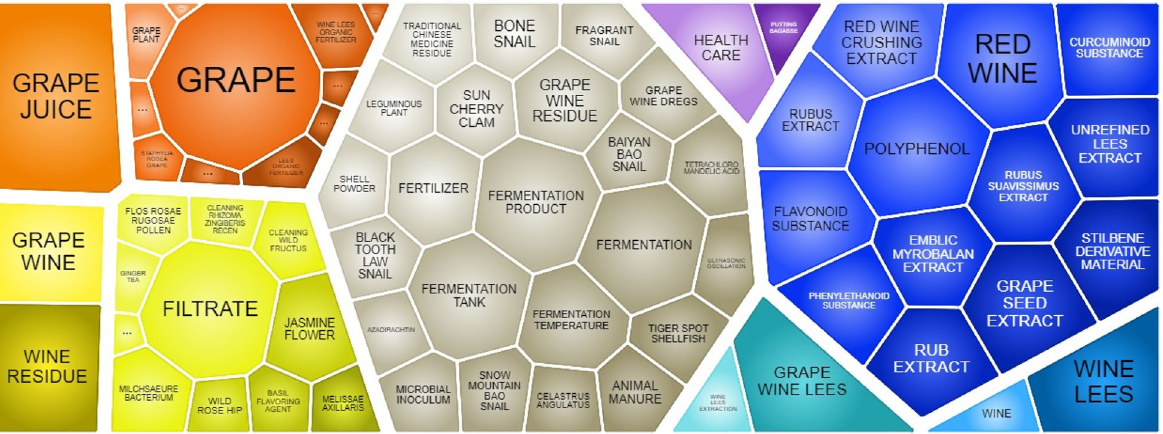
Fig. 4 Clusters of keywords related to patent documents about wine lees reuse. Source: Q. Orbit